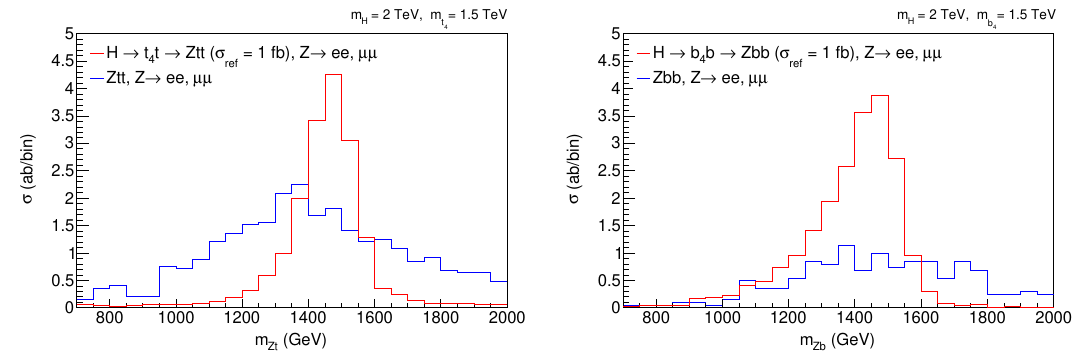
Figure 8 . Left panel: distribution of the invariant mass of the di-lepton pair plus the hardest fat- jet for the H ! t 4 t ! Ztt signal and the corresponding Ztt background, with Z ! ‘‘ ( ‘ = e; (cid:22) ). Right panel: distribution of the invariant mass of the di-lepton pair plus the hardest b-jet for the H ! b 4 b ! Zbb signal and the corresponding Zbb background, with Z ! ‘‘ ( ‘ = e; (cid:22) ). We take m H = 2 TeV, m t = 1 : 5 TeV and (cid:27) ( pp ! H ! t 4 t ! Ztt ) = (cid:27) ( pp ! H ! b 4 b ! Zbb ) = 1 4 ;b 4